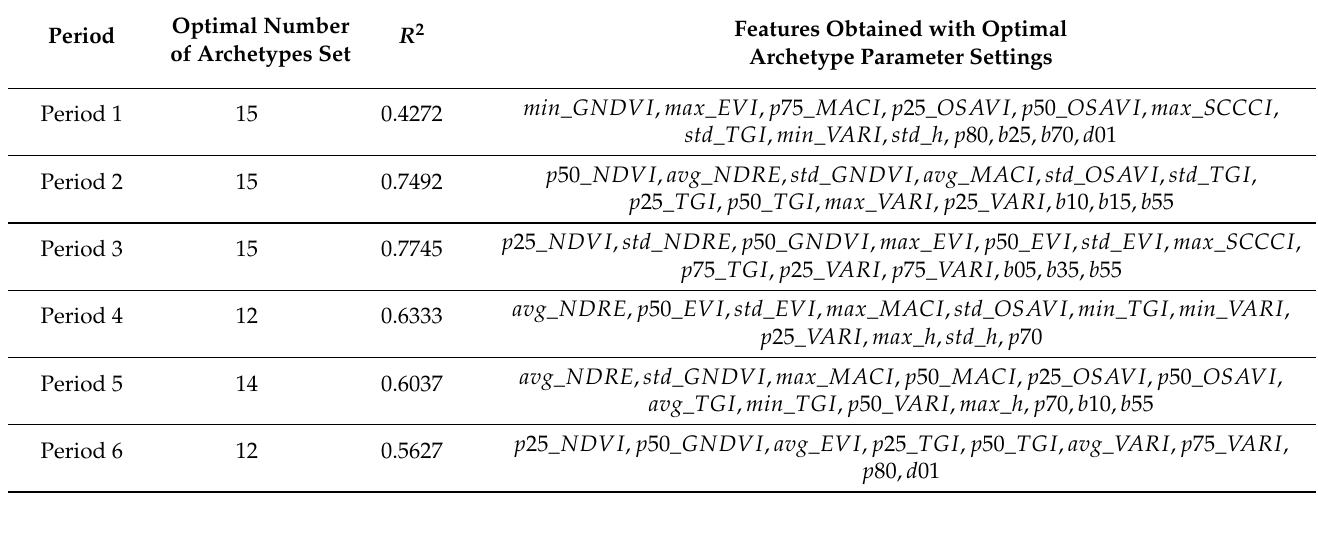
Table 1. Selection of key indicators from multispectral and LiDAR data features.